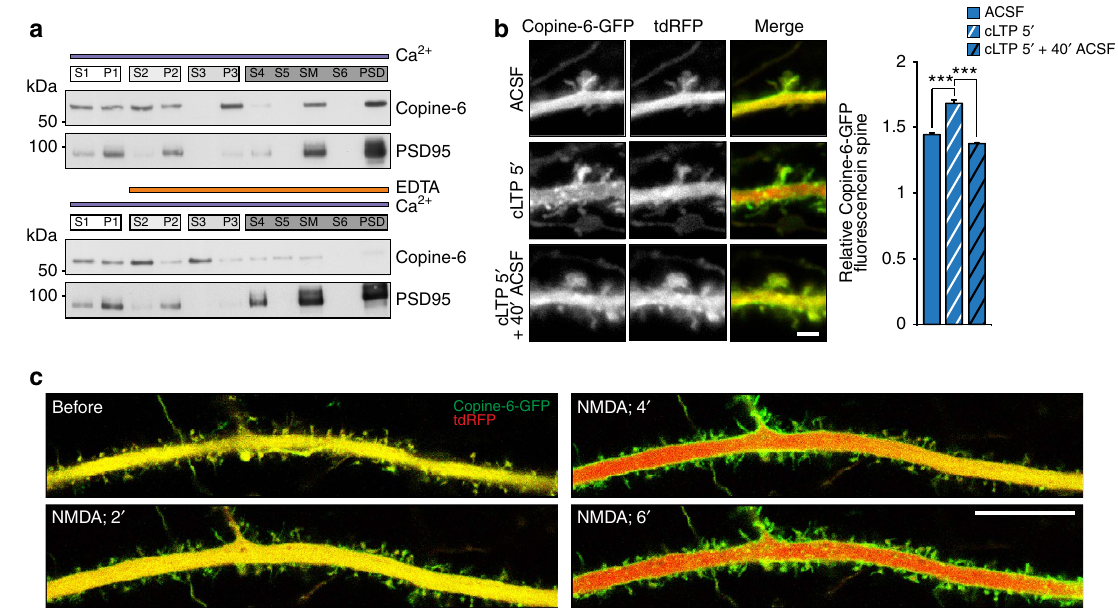
Figure 2 | Copine-6 accumulates in spines on NMDA-mediated calcium influx. ( a ) Subcellular fractionation of adult rat brain in the presence of calcium (top) or EDTA, added after the first centrifugation step (bottom). P1–P3, pellets; PSD, postsynaptic densities; S1–S6, supernatants; SM, synaptic membranes (see Methods for details). ( b ) Representative pictures (left) and quantification (right) of DIV21 cultured hippocampal neurons transfected at DIV14 to express Copine-6-GFP and tdRFP after the indicated treatment. For quantification, the ratio of Copine-6-GFP fluorescence in the spine to that in the dendrite was normalized to spine volume (see Methods for details). Copine-6-GFP becomes enriched in spines after 5min of cLTP (cLTP 5 0 ). The accumulation of Copine-6-GFP is lost after an additional 40min in ACSF (cLTP 5 0 þ 40 0 ACSF). Data are mean ± s.e.m. from n ¼ 500 spines per condition (25 spines per neuron from 20 neurons of each condition; from 3 independent cultures). *** P o 0.001 by one-way ANOVA with Tukey’s post-hoc test. Scale bar, 2 m m. ( c ) Time-lapse confocal pictures of DIV14 hippocampal neurons expressing Copine-6-GFP (green) and cytosolic tdRFP (red) during stimulation with 10 m M NMDA. Time points indicate minutes after NMDA application. Scale bar, 20 m